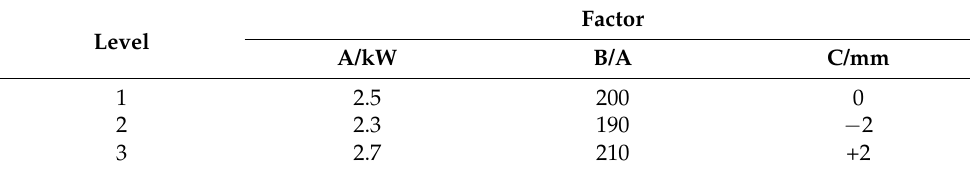
m/min, 0.8 mm, and 3.0 mm, respectively. The orthogonal test is a three-factor three-level design scheme, as shown in Table 2: A represents laser power, B represents welding current, and C represents defocusing amount. Table 2. Factor level scheme of process parameters was used in orthogonal Table 2. Factor level scheme of process parameters was used in orthogonal experiment.